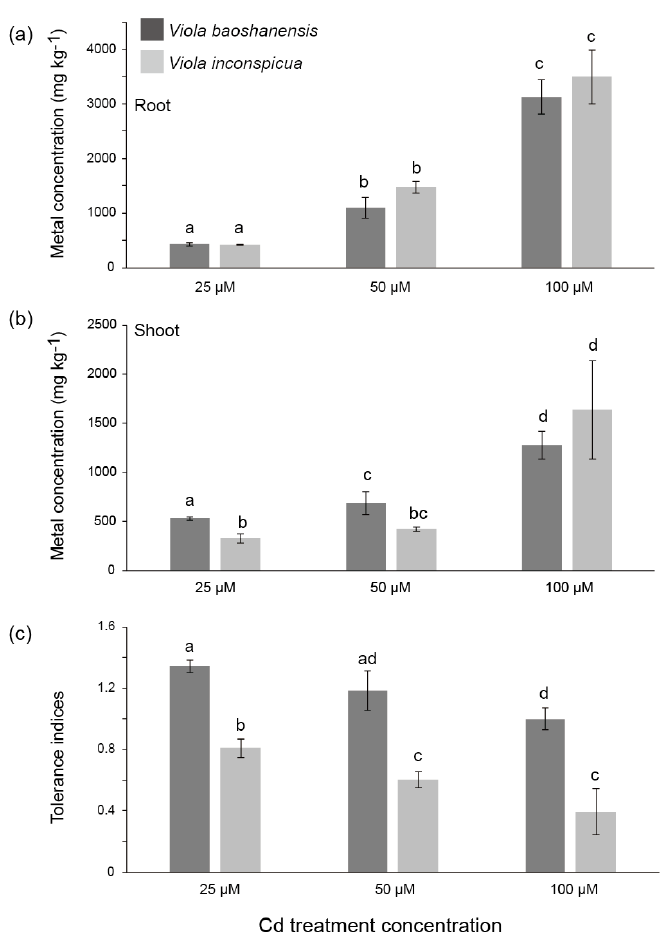
Figure 1. Concentrations of Cd in Viola baoshanensis and V. inconspicua after different Cd treatments. ( a ) roots, ( b ) shoots, and ( c ) Tolerance indices. The different letters above the columns ( n = 4), using ANOVA analysis, indicate significant differences ( p < 0.05) among the Cd treatments.